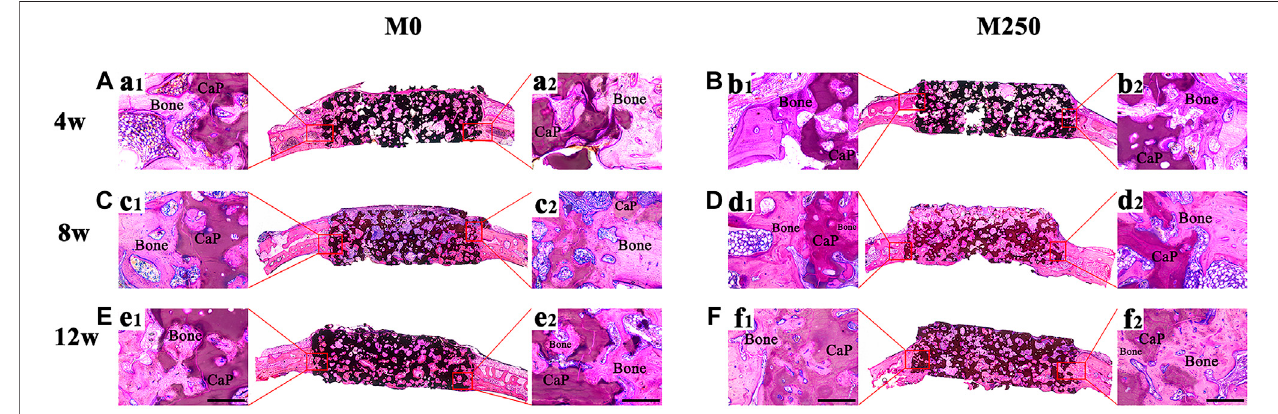
FIGURE 11 | Blood vessel formation (A) – (F) New blood vessel formation in M0 group and M250 group at week4 week8 and week12; (A) – (F) Magni fi ed view of blood vessel withinM0 and M250 scaffolds (red arrow); (G) Theratioofblood vesselareabetweengroup M0 and group M250; (H) VEGFand (I) FGFmRNA expression in implantations (scale (cid:2) 500 µm), Bone: bone tissue; CaP: CaP ceramic (Statistically signi fi cant differences are marked by * p < 0.05).